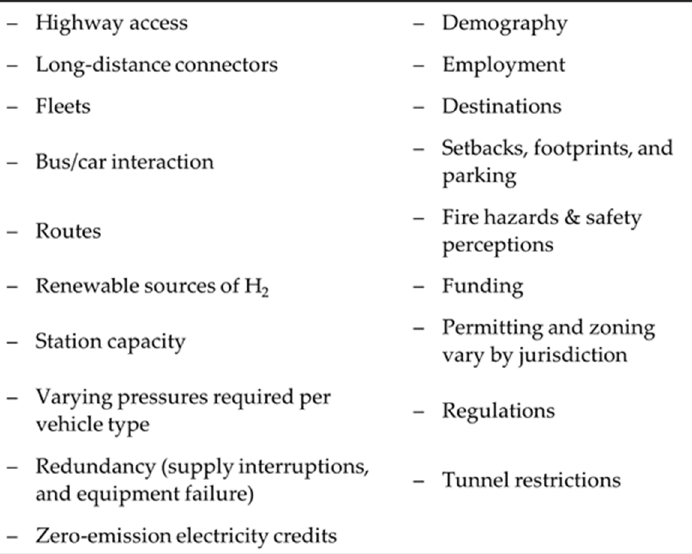
Figure 4. Important factors to HRS siting determined by workshop participants prior to delibera- tion.